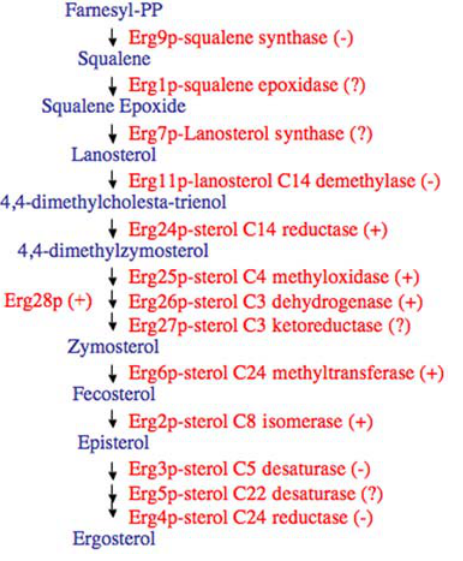
Figure 1. Outline of the ergosterol synthesis pathway in yeast. ( + ) the corresponding gene is present in C. elegans and D. melanogaster , according to our exploration. ( 2 ) the corresponding gene is absent. (?) not convincing evidence for the presence of the ortholog.